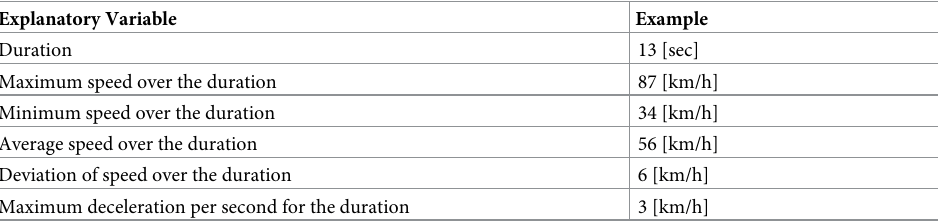
Table 1. Example of the automotive sensor index for estimating accident